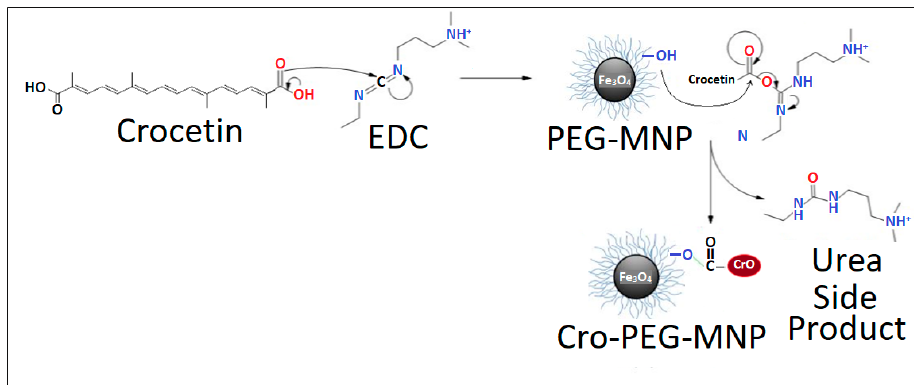
Scheme 2. Representation of the possible binding mechanism of crocetin to PEG-MNPs. Table 1. Loading capacity of crocetin-functionalized PEG-MNPs via waste analysis.